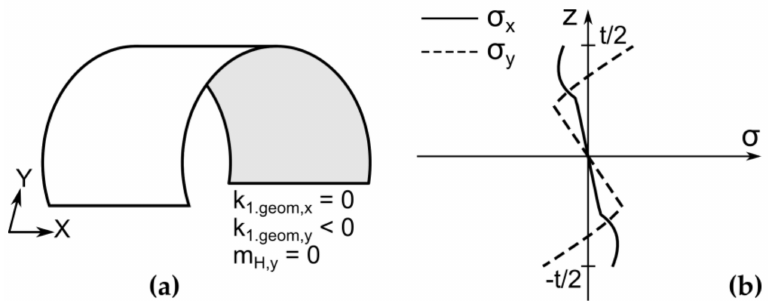
Figure 9. Shell geometry ( a ) and stress distribution along the shell thickness ( b ) at first stable